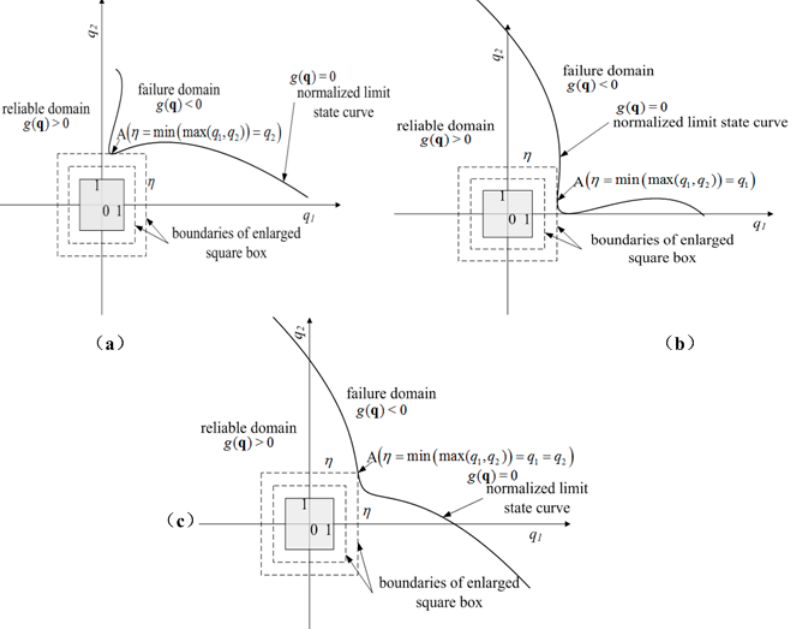
Figure 1. Diagrammatic presentation for non-probabilistic reliability index (NPRI) of a system with two intervals, ( a ) normalized limit state function (LSF) intersects with enlarged square box at one side, ( b ) normalized limit state curve (LSC) intersects with enlarged square box at another side, and ( c ) normalized limit state curve intersects with enlarged square box at cater-corner point.